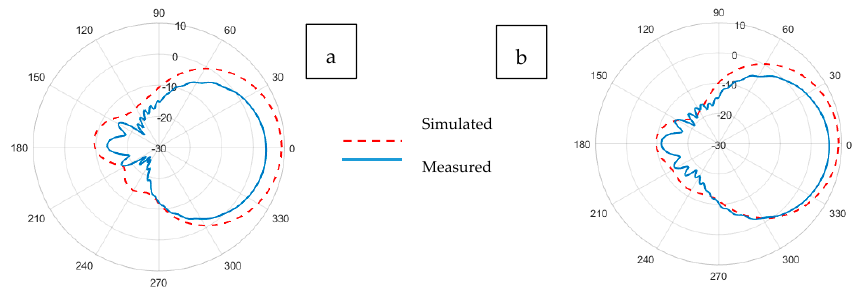
Figure 16. Simulated and experimental ( a ) E-plane and ( b ) H-plane radiation patterns of Koln-based perforated RRMPA at 2.45 GHz.